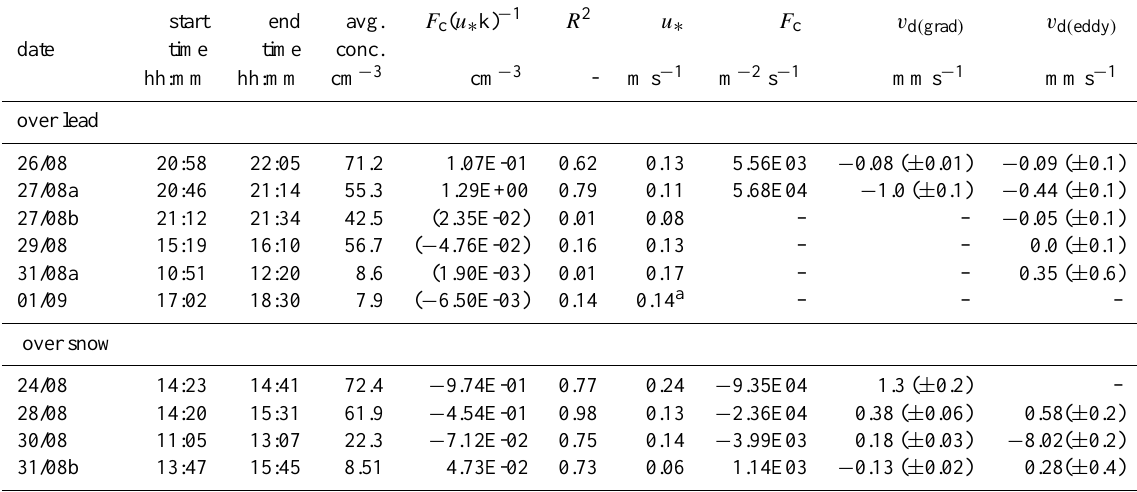
Table 4. Summary of particle concentration slope parameters, aerosol number flux F c , and deposition velocity v d over the lead and snow surfaces; values in parentheses are discarded due to rejection by standard errors or by low coefficients of determination R 2